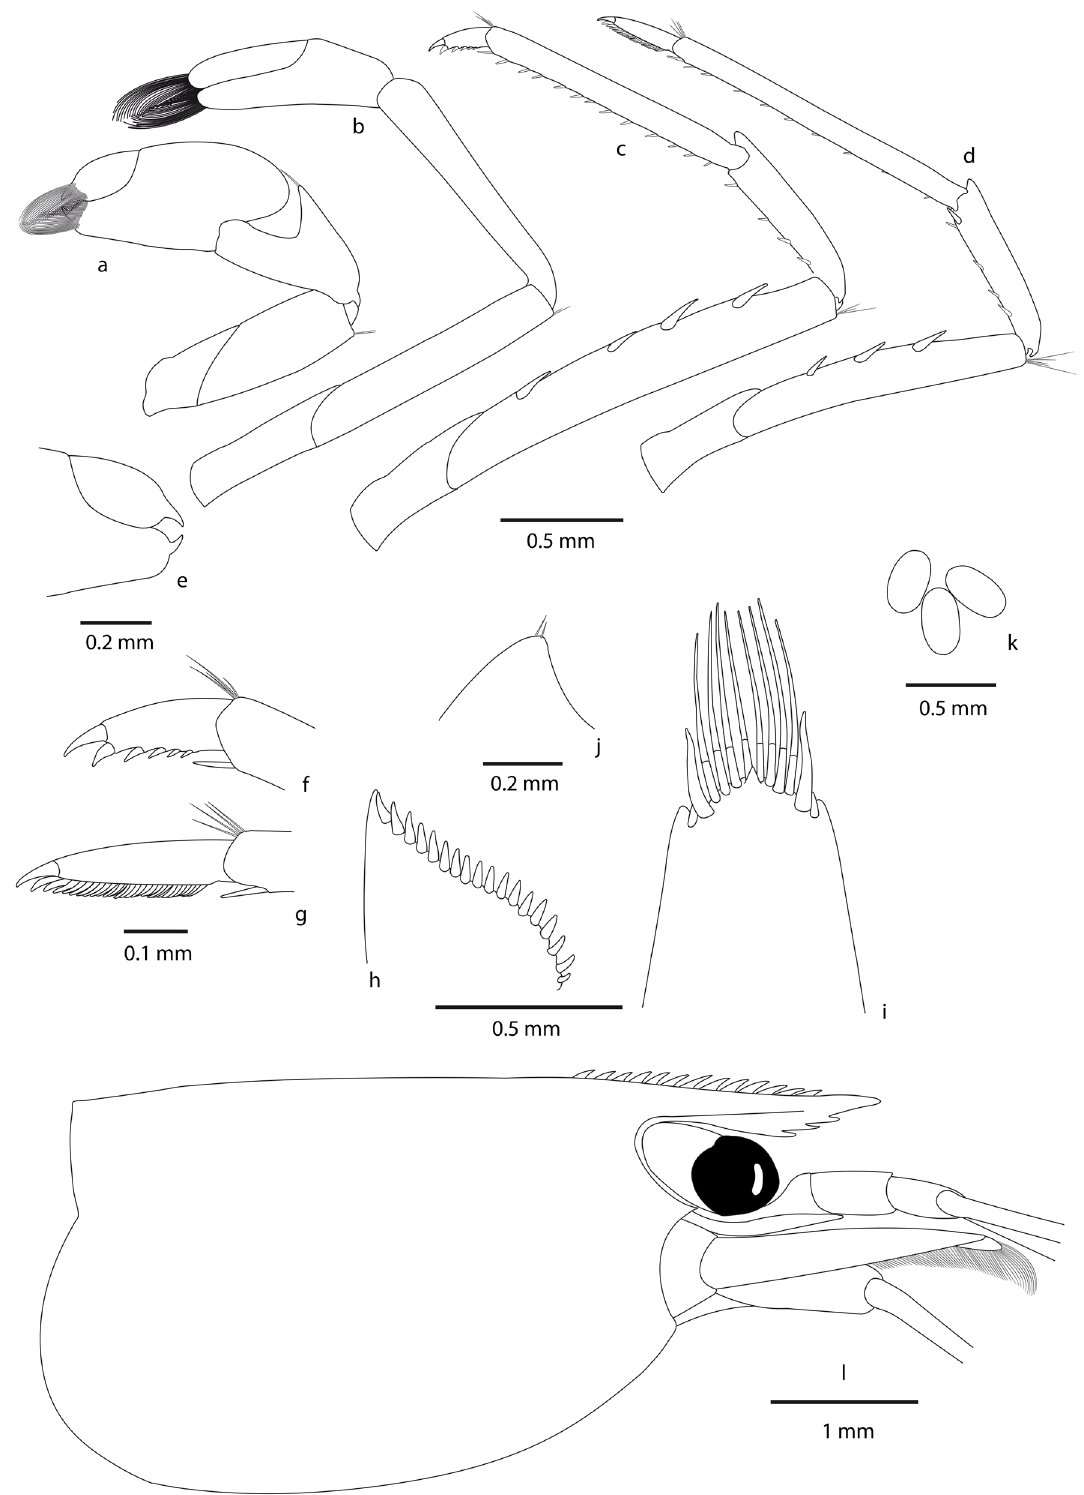
Fig. 12. Caridina buehleri Roux, 1934. a . First pereiopod. b . Second pereiopod. c . Third pereiopod. d . Fifth pereiopod. e . Dactylus of third pereiopod. f . Dactylus of fifth pereiopod. g . Pre-anal carina. h . Uropodal diaeresis. i . Telson. j . Pre-anal carina. k . Eggs. l . Cephalothorax. MNHN-IU-2018-2845 (a–i, k), MNHN-IU-2015-20 (j) and MNHN-IU-2018-2846